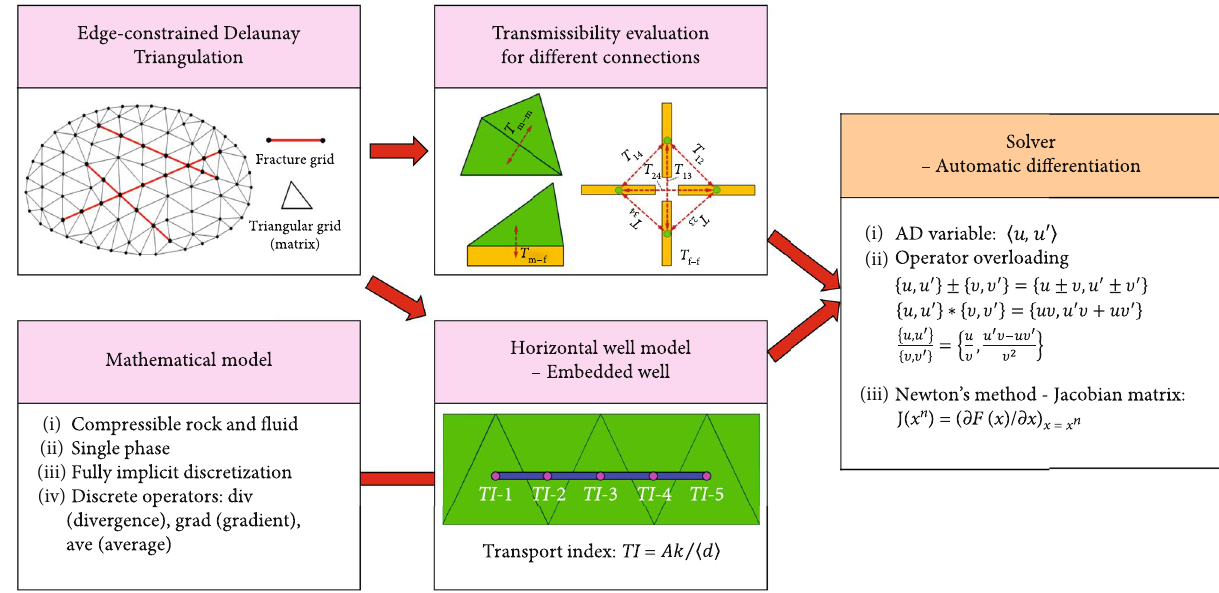
Figure 1: Framework and technical details of the